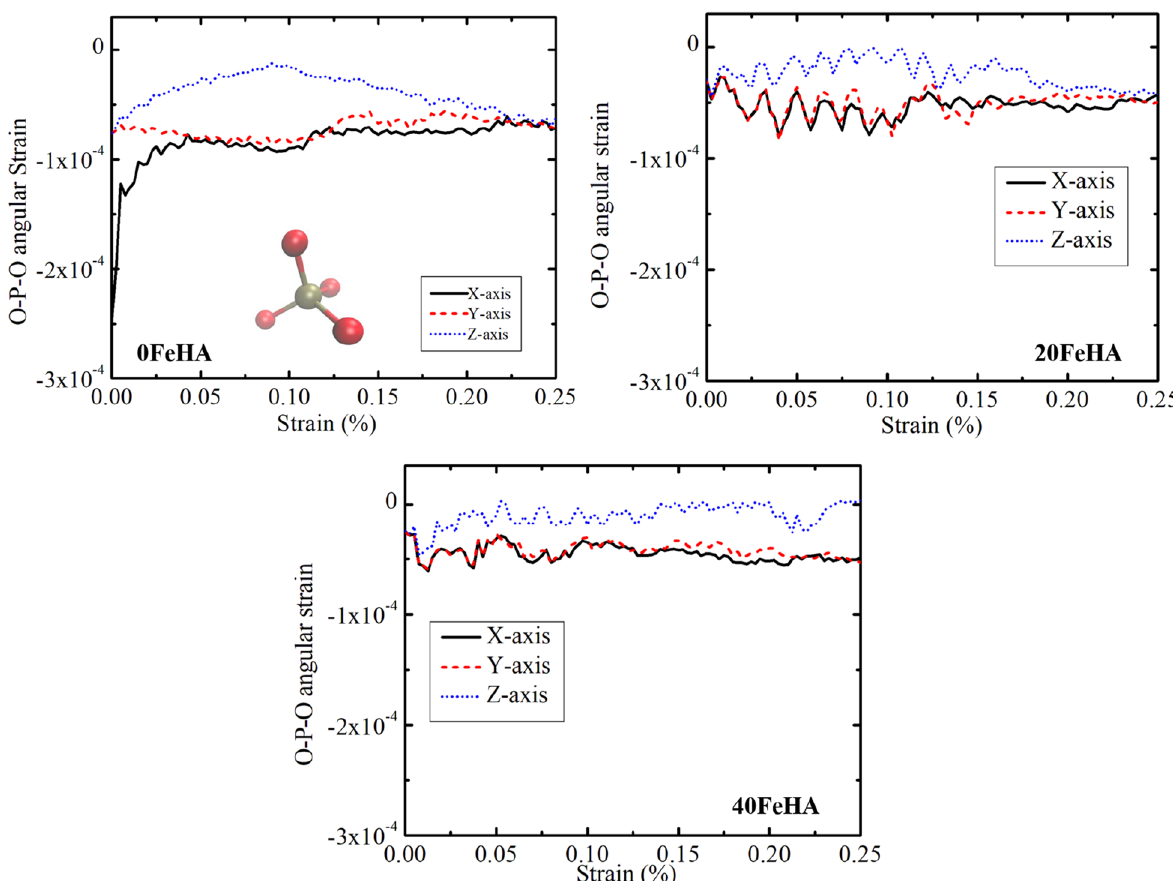
Figure 13. MD simulation analyzed variation in O–P–O angular strain during tensile loading for several Fe-doped HA at T = 10 K. Phosphate group is shown in the inset, with atomic colour code: O: red, P: golden- yellow. (Sample designation: xFeHA means x mol% Fe 2+ -doped